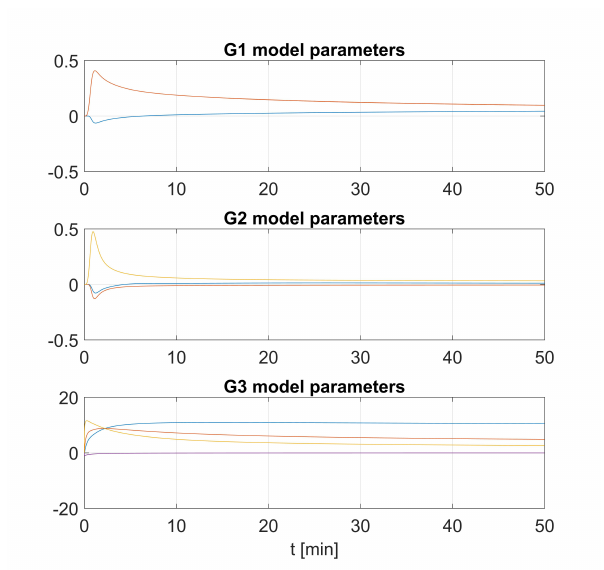
Figure 7. Identification, model